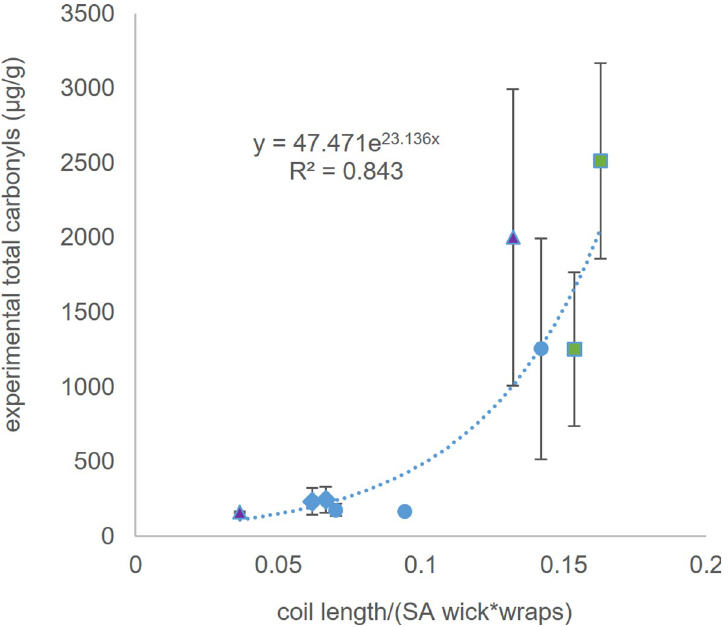
Fig 3. Total carbonyl emissions per e-liquid consumed as a function of coil length per the product of outer surface area of wick and coil wraps (1). Dashed line represents best fit regression (R 2 = 0.843). Each carbonyl was analyzed by HPLC (see methods section). Error bars represent one standard error. The larger error bars associated with the e- cigarettes that produce high levels of toxins are expected based on previous literature [4,25]. Higher concentrations of carbonyls suggest inefficient wicking that produce a higher degree of error exacerbated by intra-device inconsistencies. EC1-9 are various brands of e-cigarettes with differing wicks, coils and coil styles (see Supporting Information). Blue circle symbols represent devices with single coil style, green square symbols represent devices with parallel coil style, and purple triangle symbols represent devices with dual coil style.